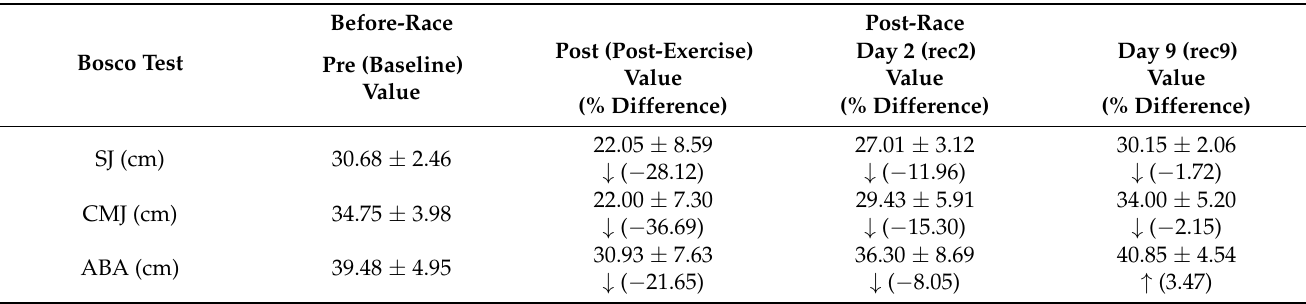
Table 4. Neuromuscular function before (baseline) and after race (post-exercise Day 2 and post- exercise Day 9).